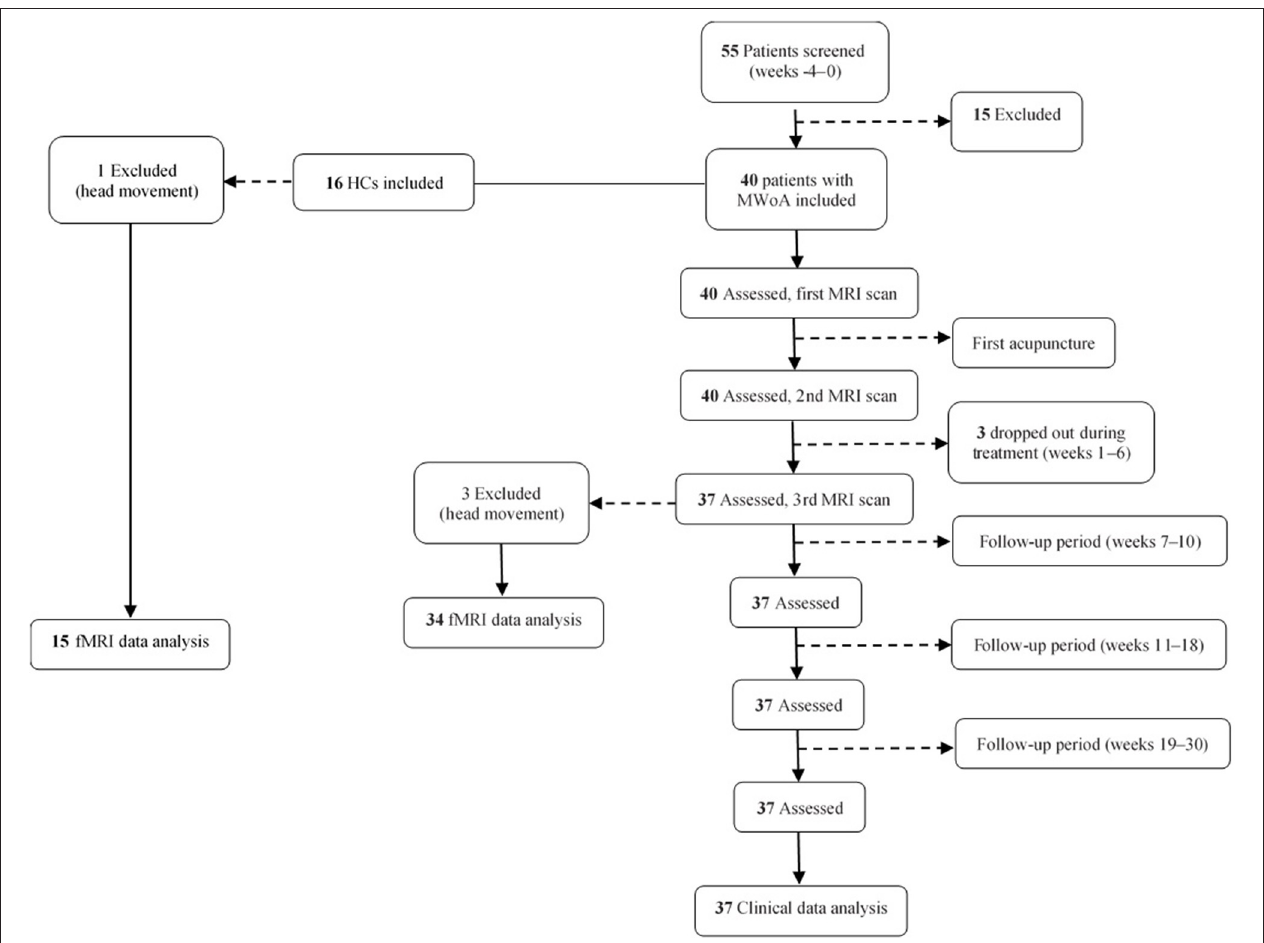
FIGURE 1 | Flow chart showing the screening, enrollment, treatment, and follow-up periods. fMRI, functional magnetic resonance imaging; MRI, magnetic resonance imaging; MwoA, migraine without aura.